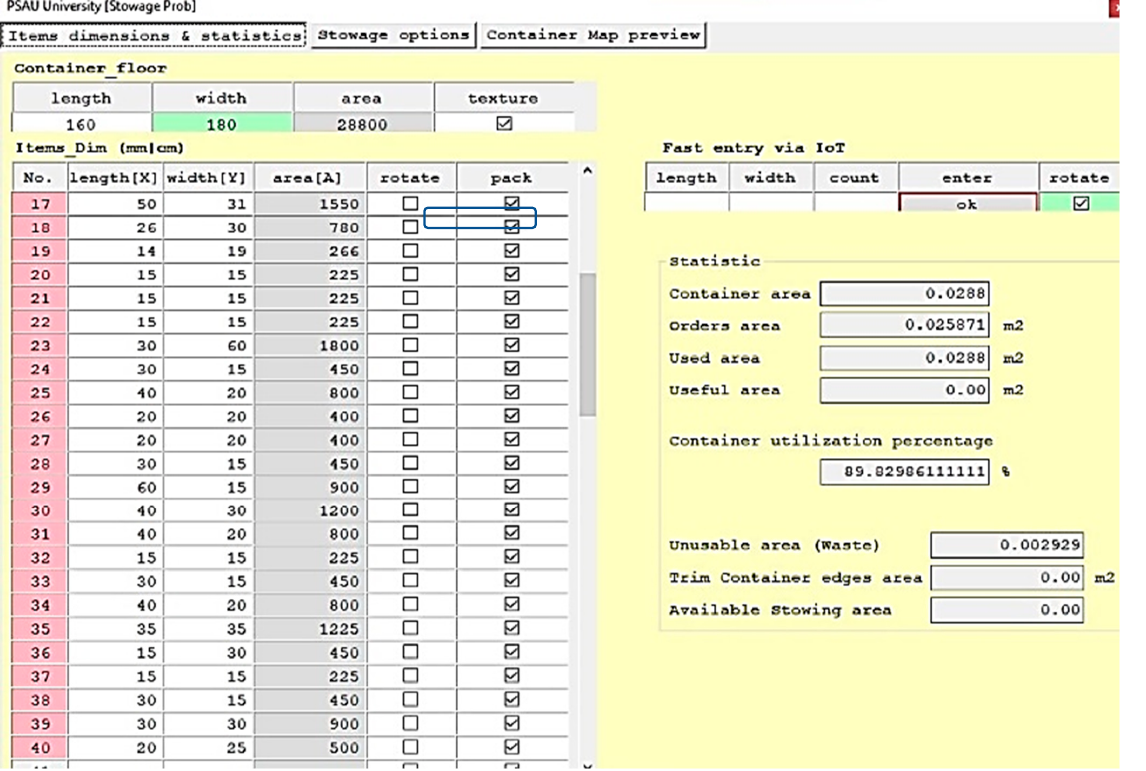
Figure A9. The stowage map by proposed algorithm optimization OSM-CA.